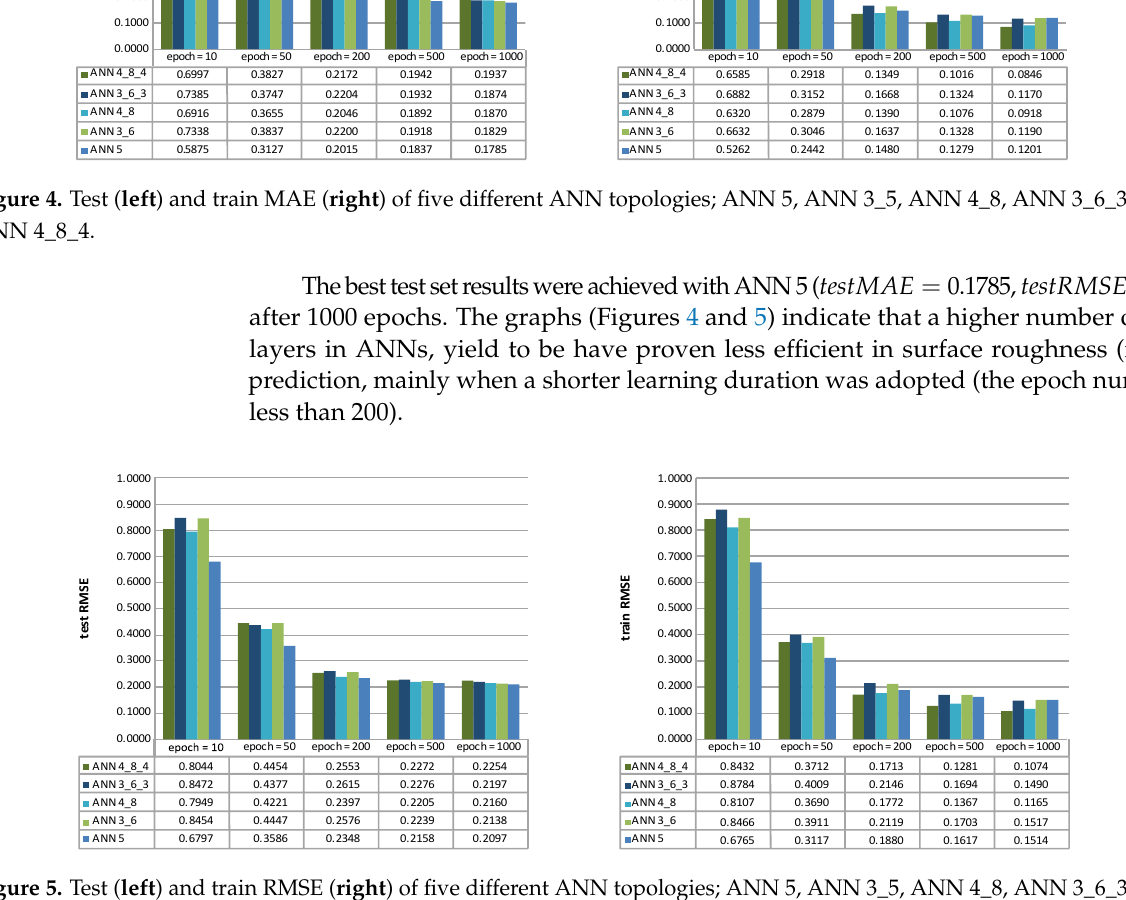
Figure 5. Test ( left ) and train RMSE ( right ) of five different ANN topologies; ANN 5, ANN 3_5, ANN 4_8, ANN 3_6_3, and ANN 4_8_4.